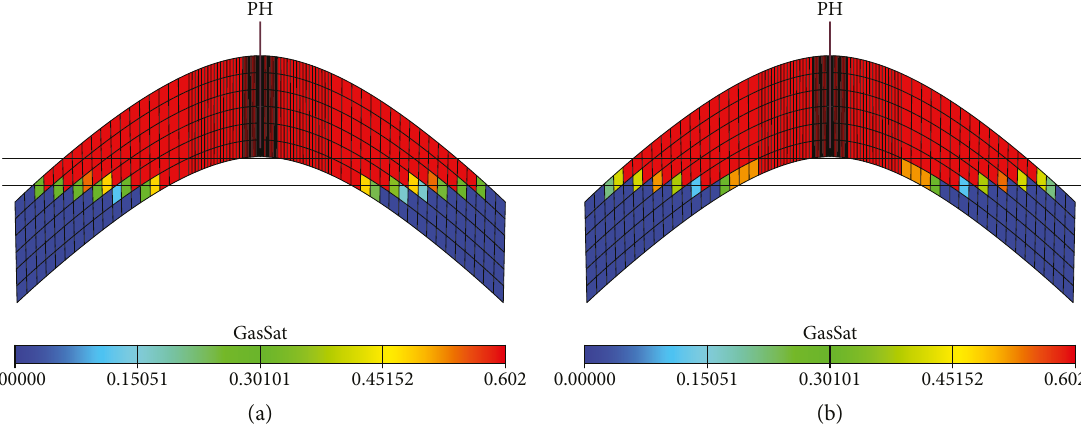
Figure 23: (a) The initial oil-water contact (OWC). (b) The oil-water contact at 1060 days, according to the saturation pro fi le. The distance of movement for saturation front with time is about 27.7ft.